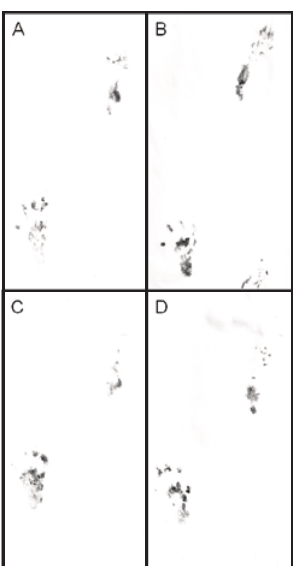
FIGURE 1 - Representative footprints analysis performed on autograft and latex conduit implanted rats. At four weeks after surgery ( B ), latex conduit rats show better gait trail than autograft operated rats ( A ), with right dragging feet (operated leg). At eight weeks p.s. gait in latex conduit operated ( D ) is even better than that of autograft ( C ) rats.